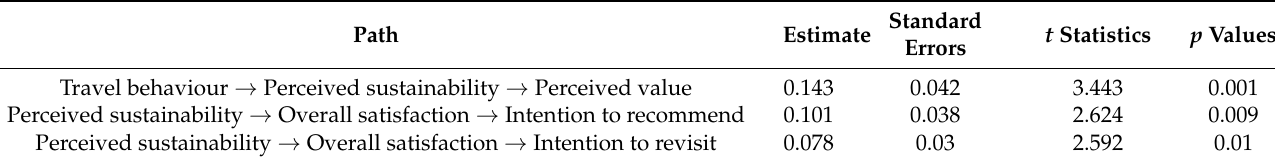
Table 3. Bootstrapping results for specific indirect effects.